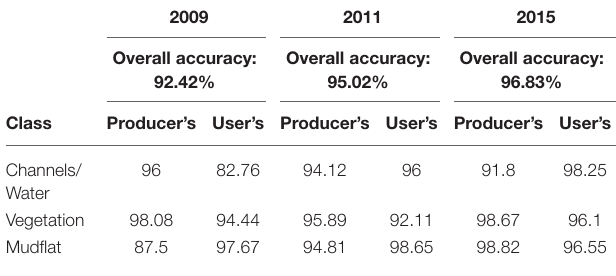
TABLE 1 | Accuracy assessment for each cover category for 2009, 2011, and 2015.